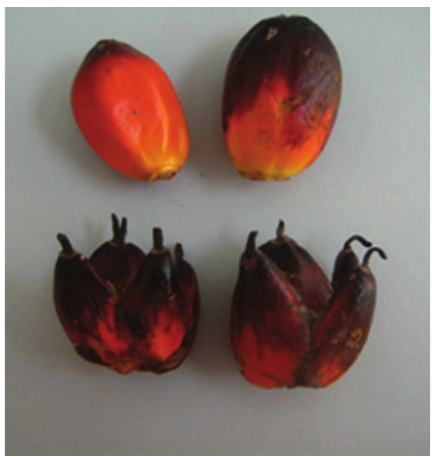
Figure 1: Comparison between phenotypically normal (top) and mantled fruits (bottom). Source: from Advance Agricultural Resources Pty Ltd